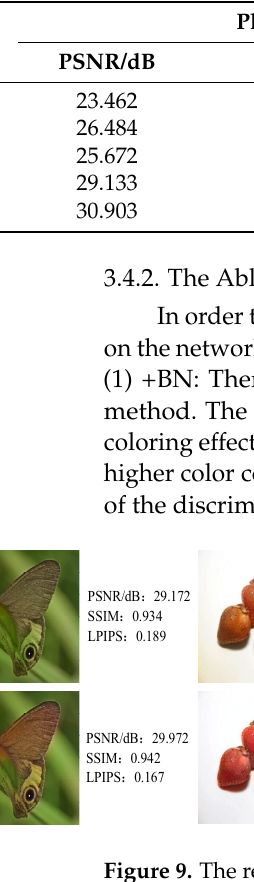
Table 5. Ablation experiment of the network structure.